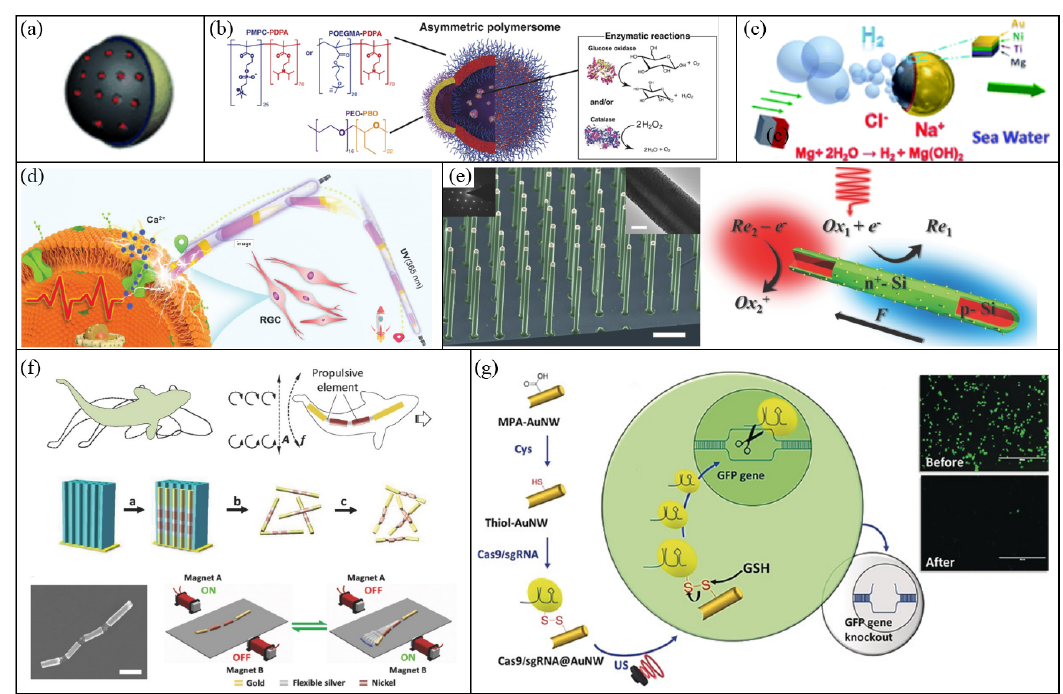
Figure 2. Examples of Janus spheres and nanowires designed for MNMs. ( a ) Self-propelled Janus mesoporous silica nanomotors for drug delivery. Reprinted with permission from [76]. ( b ) Schematic representation of an asymmetric chemotactic vesicle (polymersome). Reprinted with permission from [86]. ( c ) An illustration of a magnetic field-guided microsphere swimming in sea water through bubble recoil. Reprinted with permission from [29]. ( d ) An illustration showing TiO 2 -Au nanowires used for subretinal repair. Reprinted with permission from [100]. ( e ) Spectrally tunable light-driven silicon nanowires. Reprinted with permission from [101]. ( f ) Magnetic field-powered flexible nanowires under an oscillating magnetic field. Reprinted with permission from [103]. ( g ) A schematic graph showing acoustic field-actuated nanowires used for genetic editing. Reprinted with permission from [110].